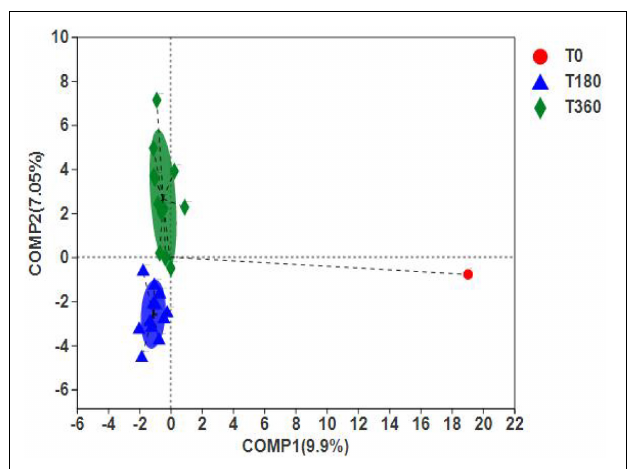
FIGURE 8 | Differences between dominant genera (A) and significant species (B) in barley at different storage periods. The bar length of each genus represents the proportion of the genus in the sample (red: storage 180 days; blue: storage 360